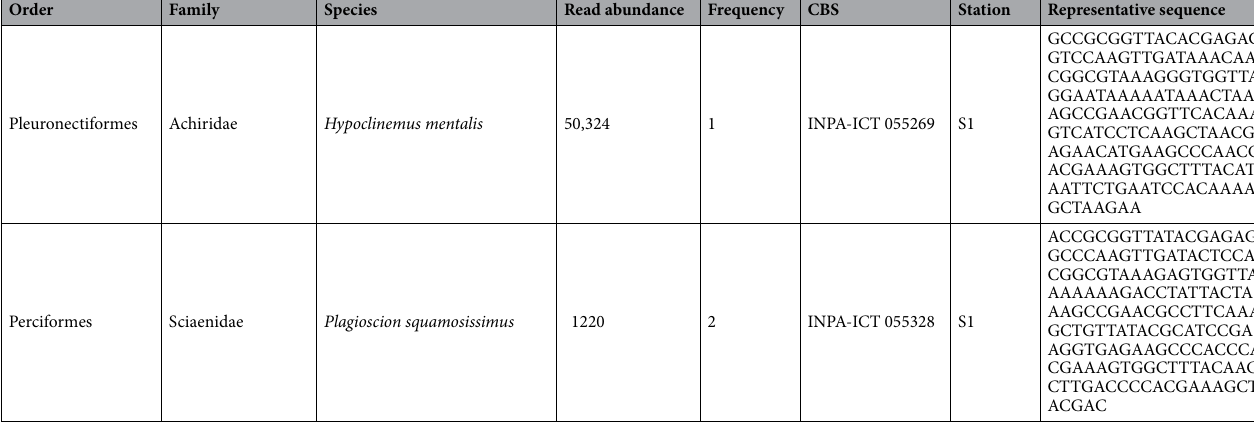
Table 1. List of 58 species identified with sequence similarities > 98.5% using the public reference libraries for 12S rRNA in the Javari River basin. S Station, S1 Javari River, S2 Terra firme stream, S3 Quixito River. Vouchers numbers for species detected with capture-based sampling are